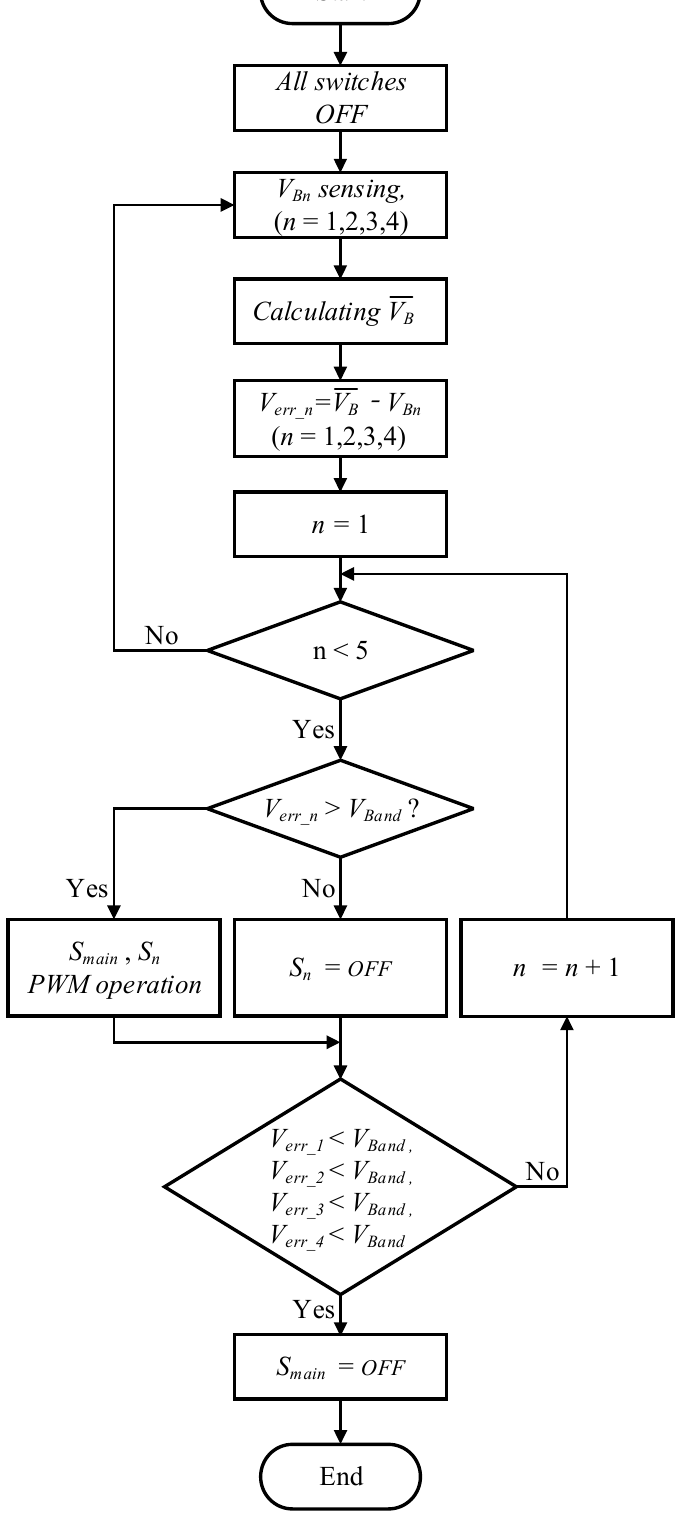
Figure 6. A flowchart for the proposed method.